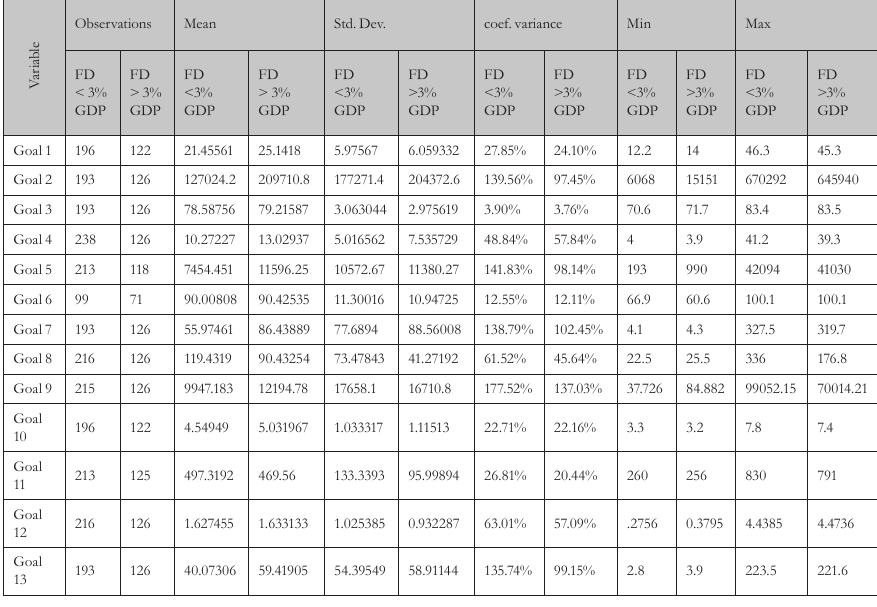
Tab.1 – Basic descriptive statistics for dependent variables for European Union countries by Maastricht deficit criterion. Source: own research